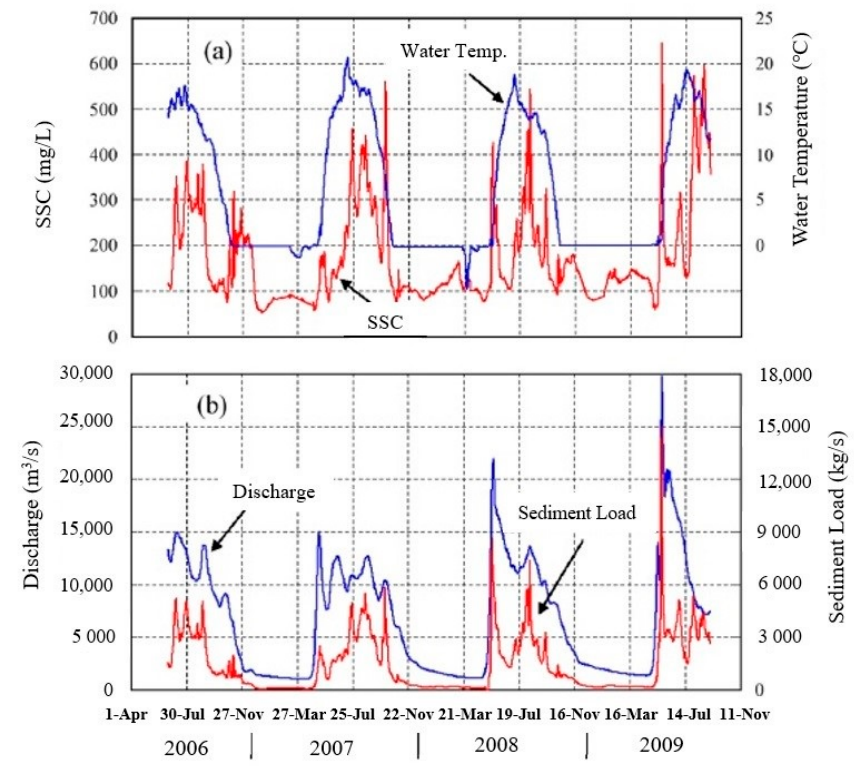
Figure 3. Temporal variations of ( a ) daily mean water temperature and SSC, and ( b ) daily mean discharge and sediment load at site PLS in June 2006–September 2009 (modified after Chikita et al.